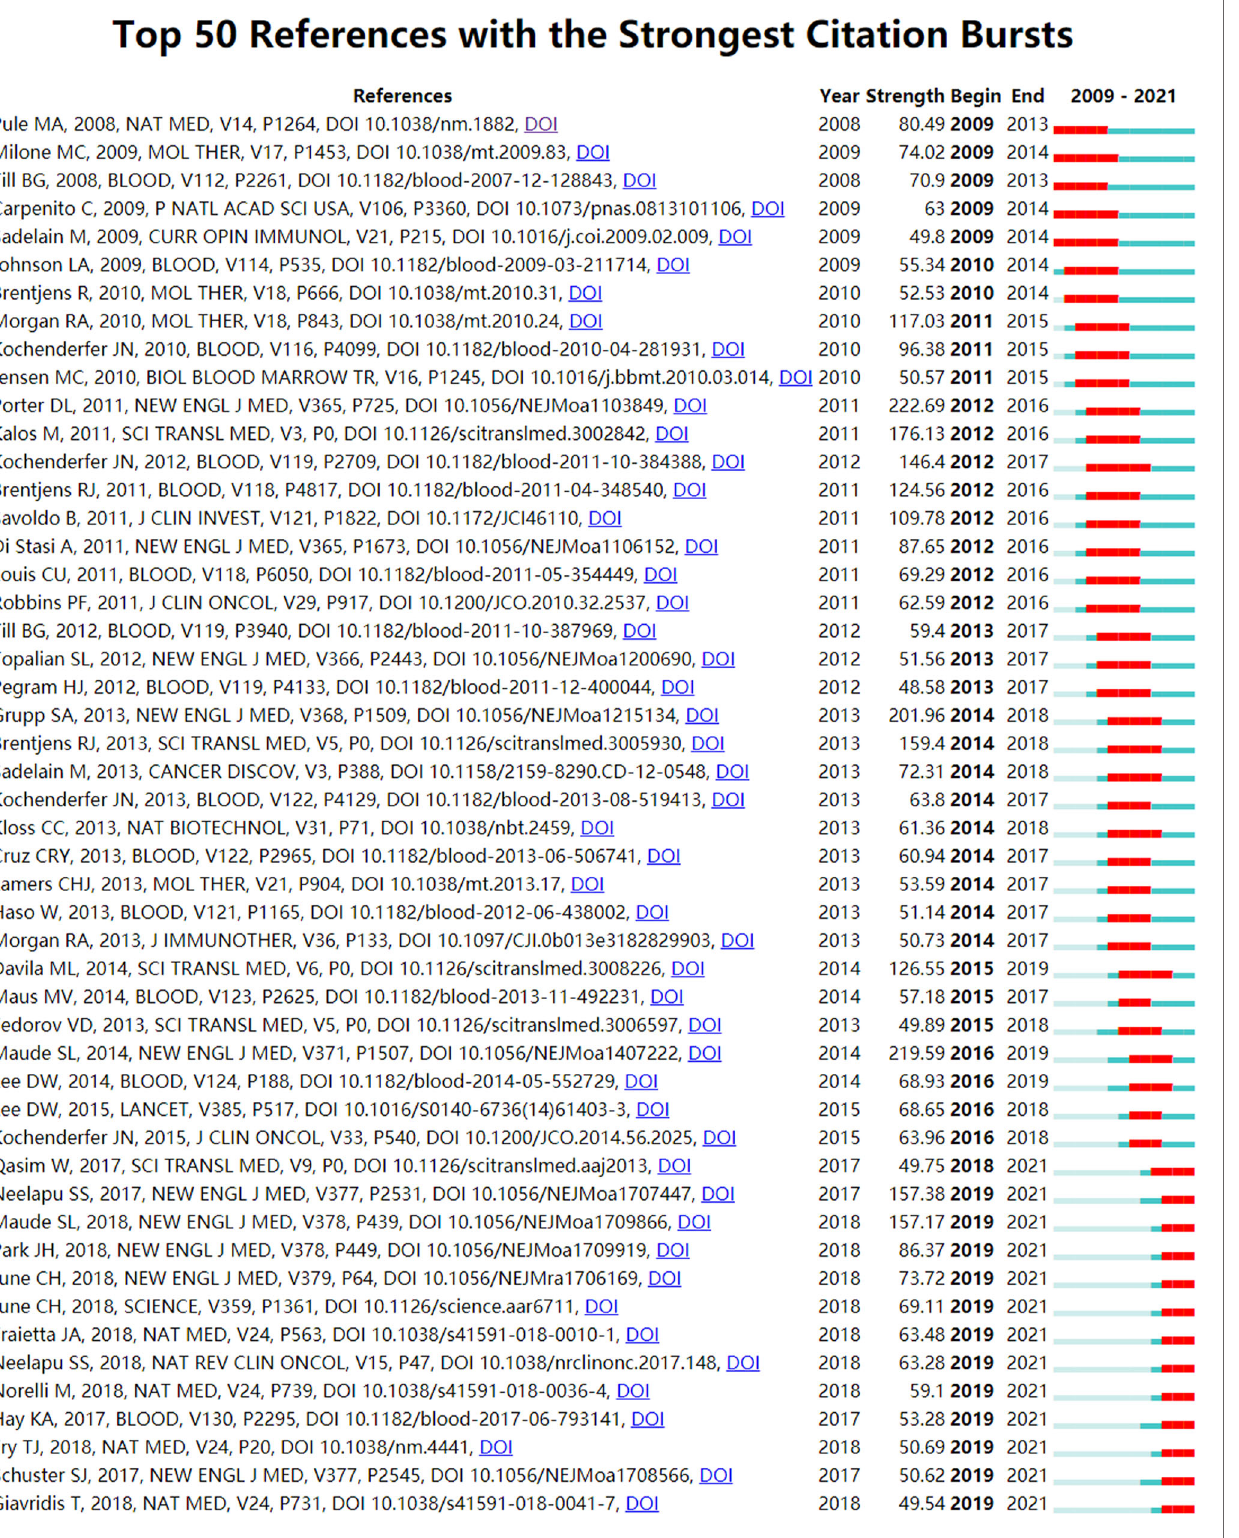
FIGURE 10 | The top 50 references with the strongest citation bursts involved in CAR-T cells. The Blue bars mean the reference had been published; the red bars mean citation